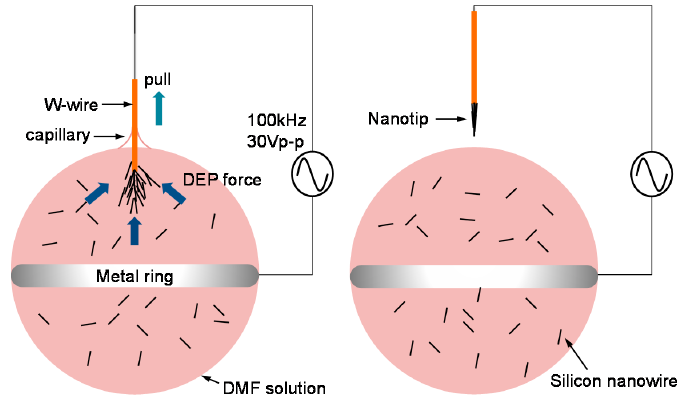
Figure 5. Nanotip fabrication method using an electric field and capillary action; Si nanowires are suspended in DMF. The suspension solution is hung on a metal coil. When a W-wire is withdrawn from the solution, a nanotip composed of Si nanowires is fabricated. The nanotip is again immersed in a SWCNT solution drop in order to coat SWCNTs.